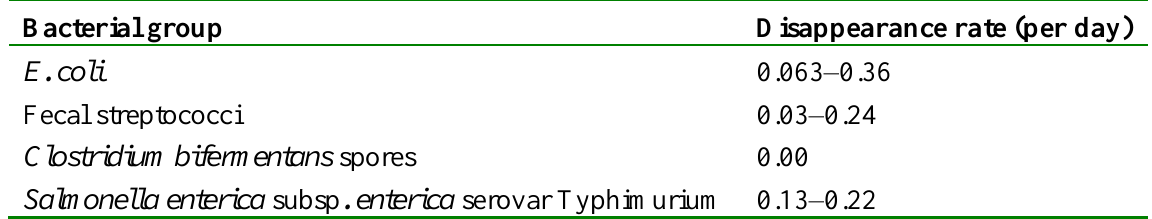
Table 10. Disappearance rates of fecal bacteria in groundwaters a